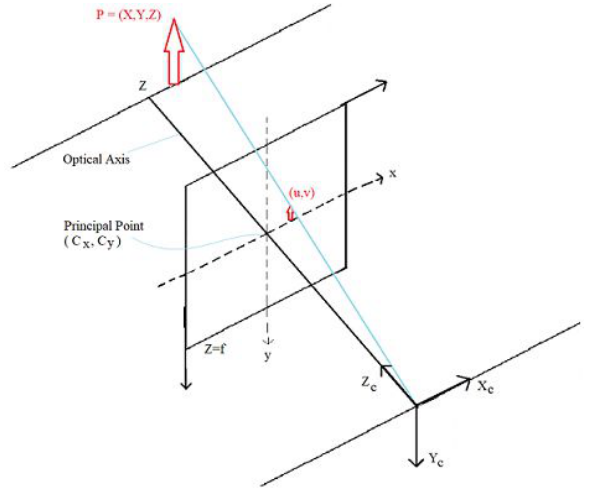
Figure 4: Pinhole Camera